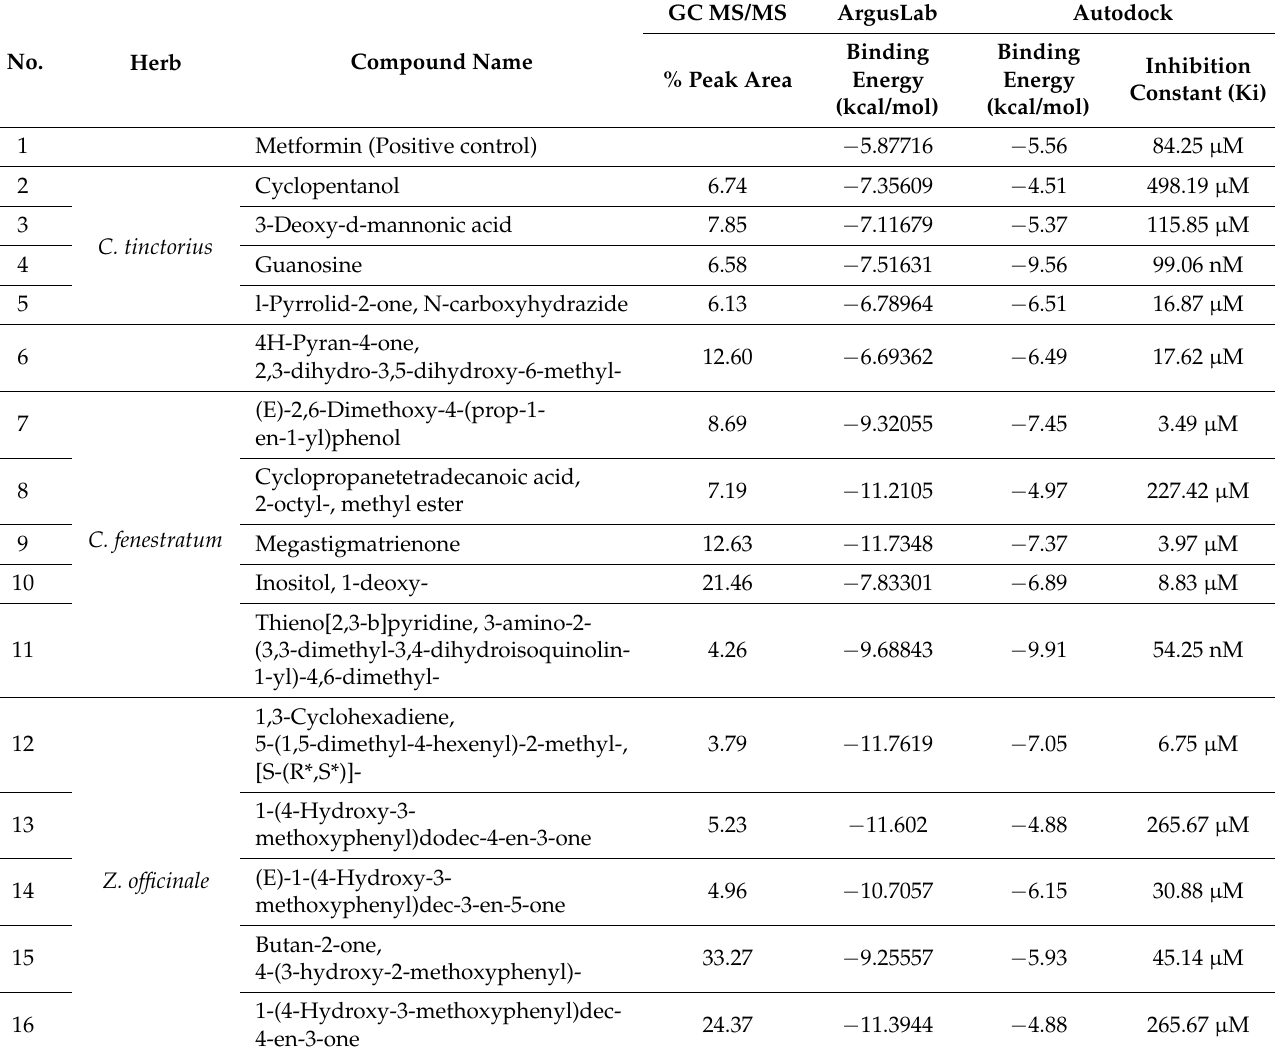
Table 16. Energy binding and phytochemical inhibition constants of herbal extracts with ethanol at the binding sites of SREBP2 from ArgusLab and Autodock analysis and quantification of each compound through GC-MS/MS